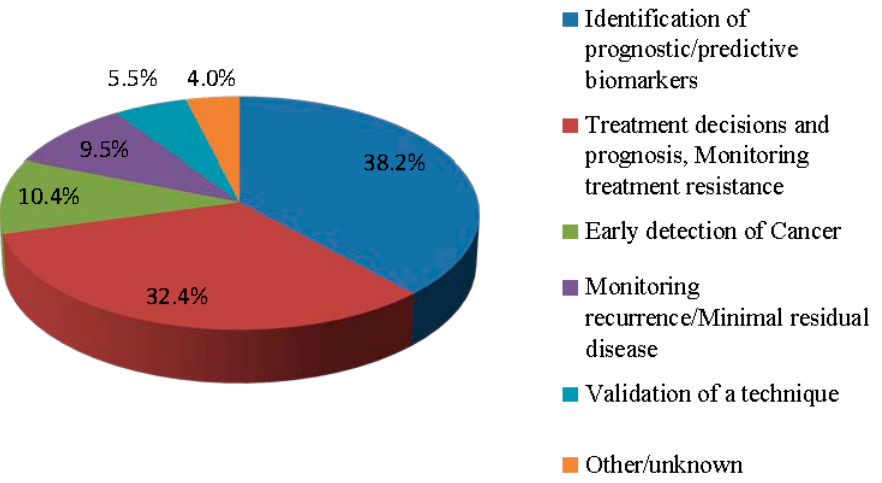
Figure 2. The workflow of cfDNA tests in clinical diagnosis, treatment and prognosis for cancer.